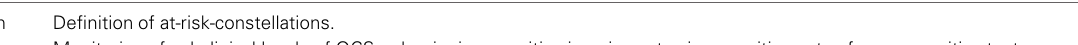
Table 3 | Therapeutic